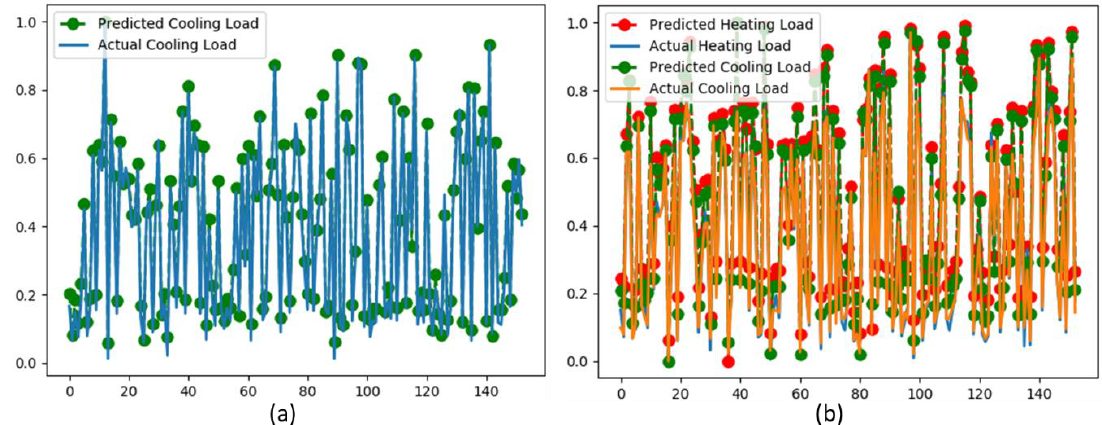
Figure 9. Visualization of prediction results obtained via the proposed model (GRU), where x -axis indicates the number of samples while y -axis represents the actual and predicted load; ( a ) the actual and predicted outputs of CL using the SO strategy; ( b ) the actual and predicted outputs of HL and CL using the MO strategy.